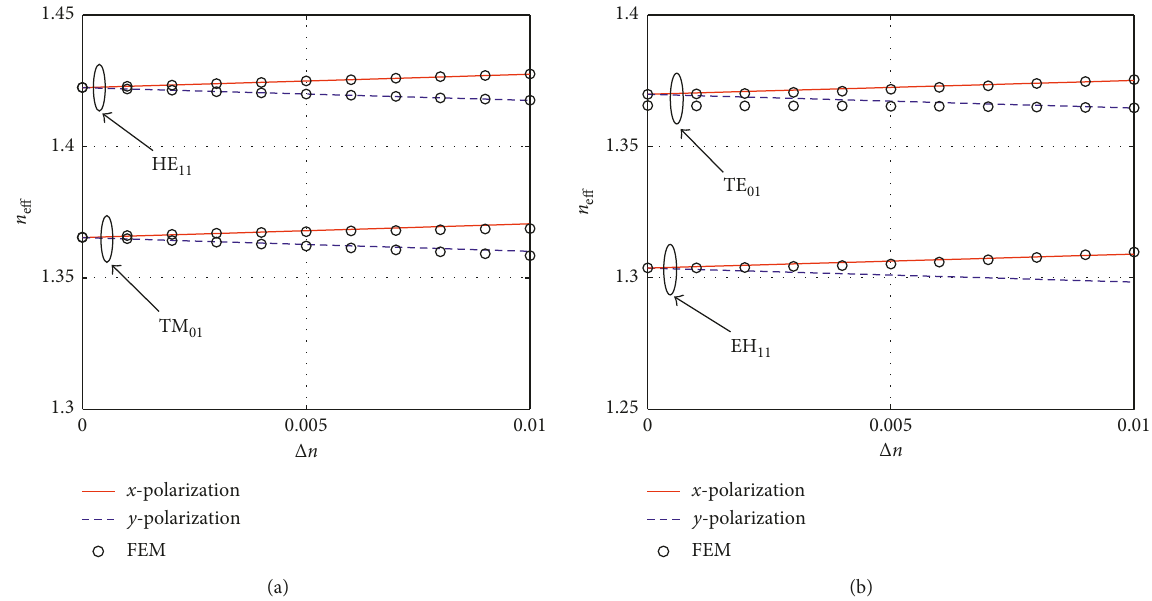
Figure 4: Effective refractive index of the optical fiber with uniaxial birefringence having the same spatial dependence of Figure 1(b) versus Δ n obtained by the HFHE formulation (lines) and calculated by the vector FEM (dots). Solid lines correspond to E x component and dashed lines to E y